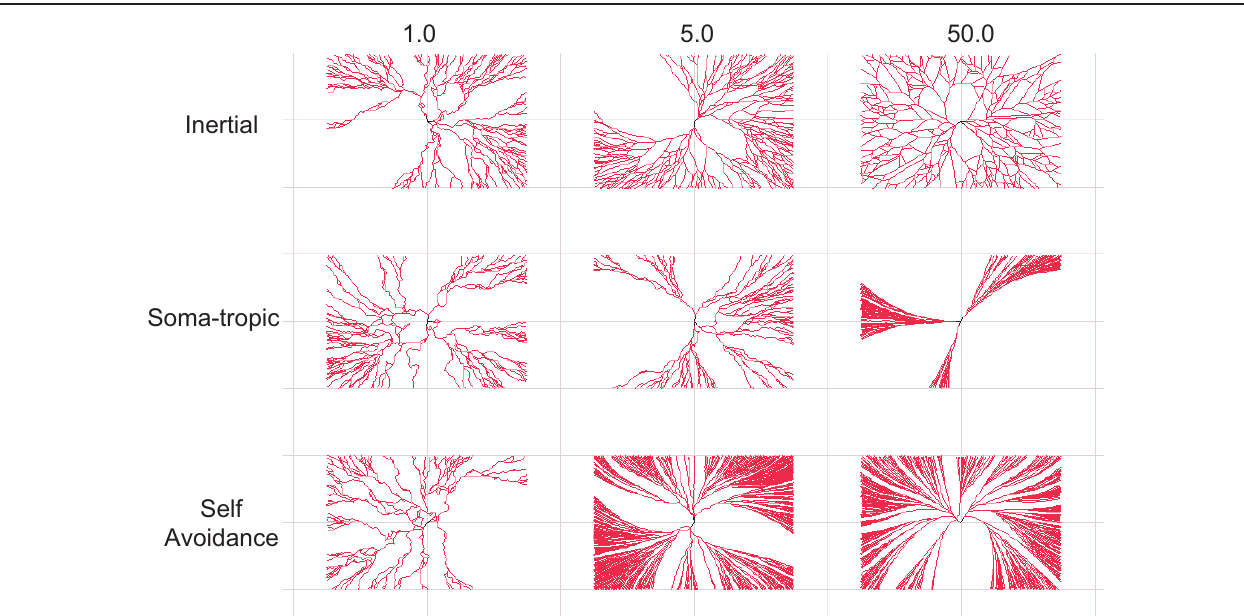
self-avoidance forces. Morphologies generated with strong inertial forces show sparse dendrites, while dense arbors require strong soma-tropic or self-avoidance forces. Inertial forces and self-avoidance grow larger structures in the same surface (space). Self-avoidance covers the surface (space) most densely. Structures are bounded by a rectangle with dimensions 150 × 100 μ